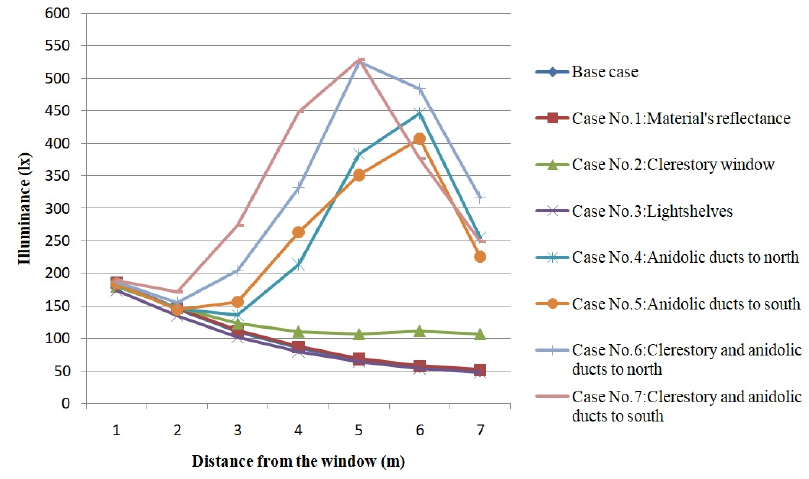
Figure 18. Comparison of average illuminance levels on the desks plane on 21 st of June at 9:00 am.